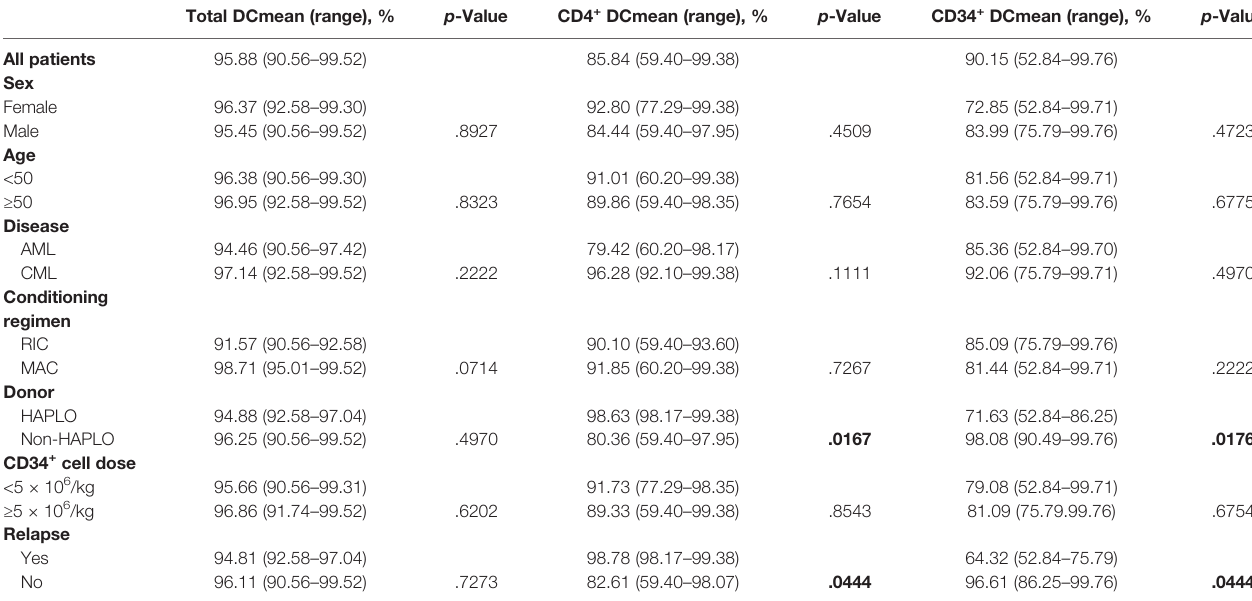
TABLE 2 | Donor chimerism in association with patient and transplant